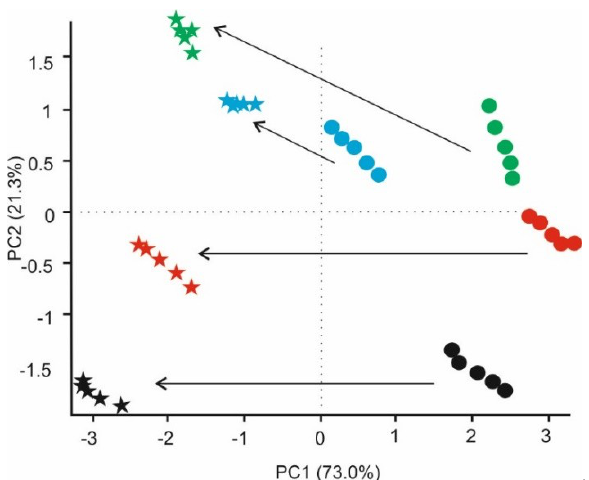
Figure 7. PCA plots for milk samples obtained from voltammetric responses in milks of sample Wlac 1 : first day ( ), fourth day ( ); sample Wlac 2 : first day ( ), fourth day ( ); sample SSnolac 1 : first day (